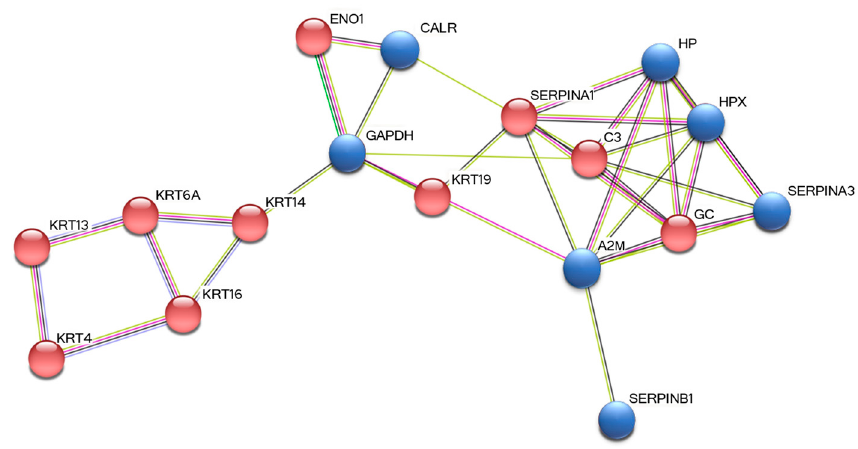
Figure 2. The functional interaction network obtained using STRING. Proteins are indicated with their gene names. Blue nodes = up-regulated proteins in D-GCF: CALR, calreticulin; GAPDH, glyceraldehyde-3-phosphate dehydrogenase; HP, haptoglobin; HPX, hemopexin; SERPINA3, alpha-1-antichymotrypsin; A2M, alpha-2-macroglobulin; SERPINB1, leukocyte elastase inhibitor. Red nodes = down-regulated proteins in D-GCF: ENO1, alpha-enolase; SERPINA1, alpha-1-antitrypsin; KRT19, keratin, type I cytoskeletal 19; C3, complement C3; GC, Vitamin-D-binding protein; KRT14, keratin, type I cytoskeletal 14; KRT16, keratin, type I cytoskeletal 16; KRT6A, keratin, type II cytoskeletal 6A; KRT13, keratin, type I cytoskeletal 13; KRT4, keratin, type II cytoskeletal 4.